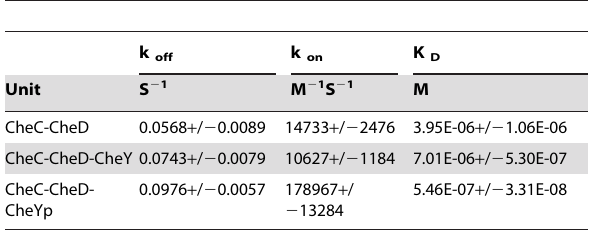
Table 1. Kinetic parameters of CheC-CheD binding from SPR